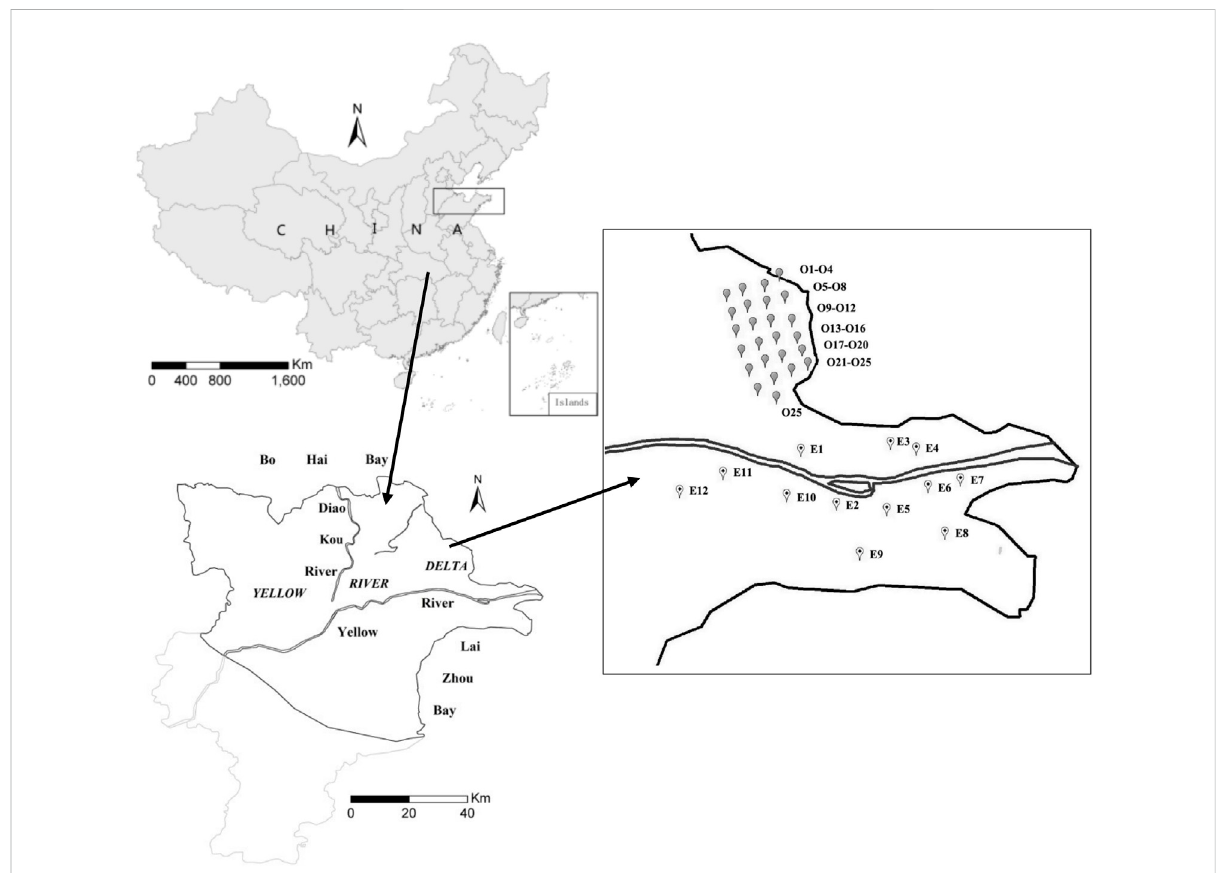
FIGURE 1 Map of sampling locations in the oil fi eld and estuary in the YRD: O1-O25 mean Oil soil samples, (b) mean Estuary soil